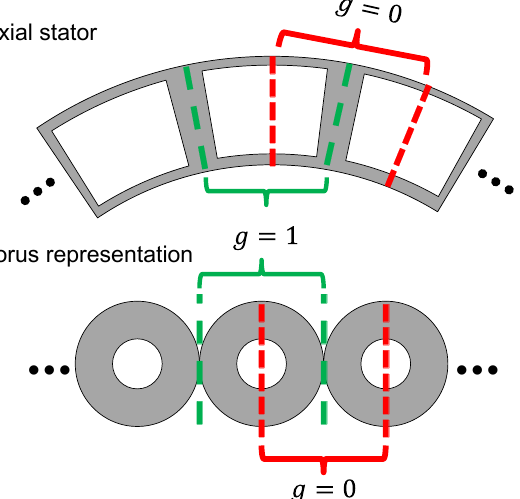
Figure 6. Correct periodic division of an axial stator. Green division is correct for both genus determination and observation domain. Red division is only correct for observation